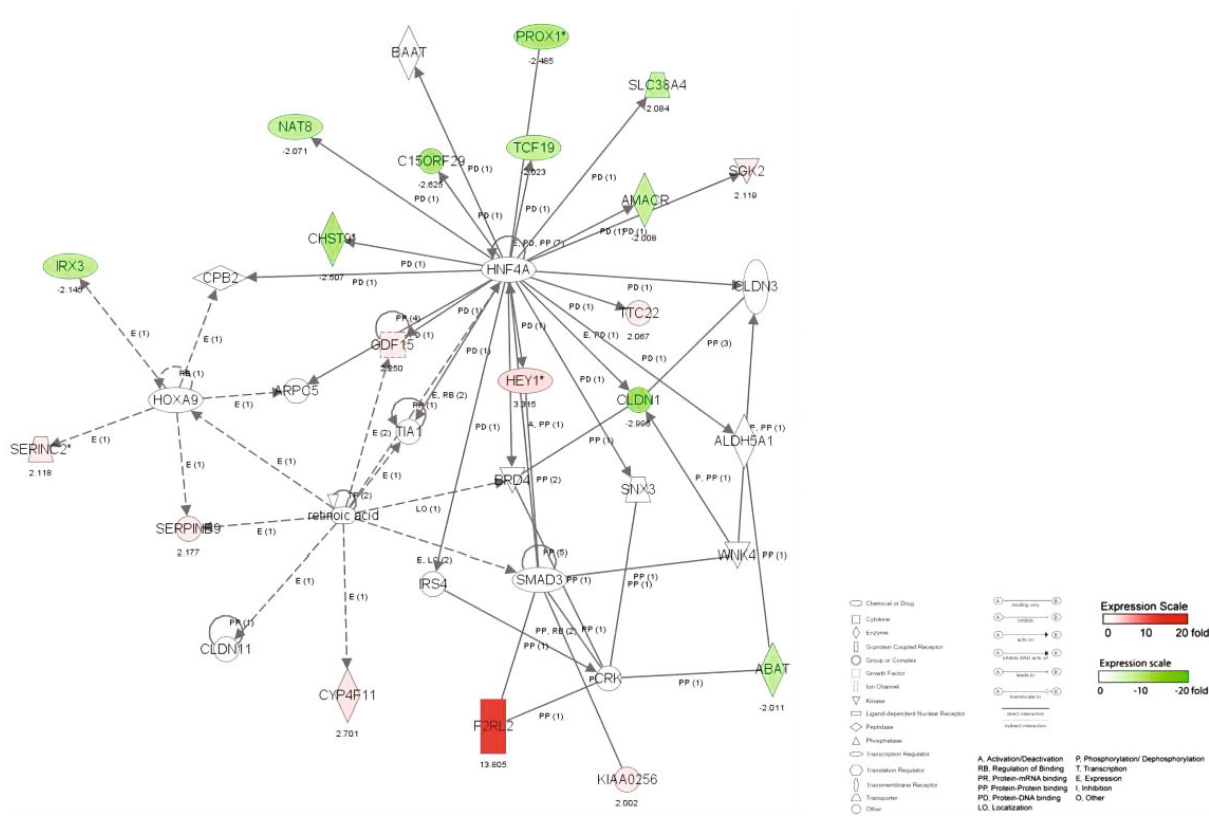
Figure 6: The third most signi fi cant molecular network a ff ected by